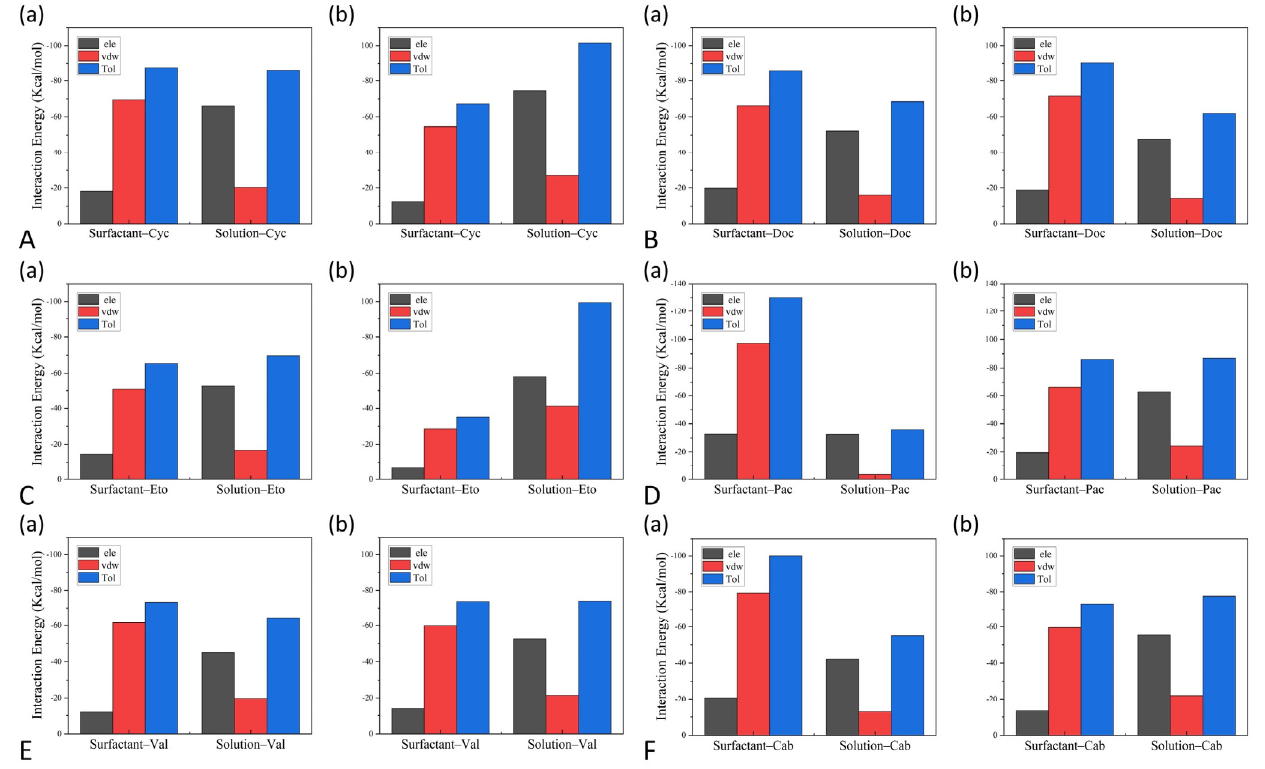
Figure 12. Interaction energies of each binary component of ( a ) the formulations without cosolvents and ( b ) the formulations with cosolvents, where ele stands for the electrostatic interaction energy and vdw refers to the van der Waals interaction energy. ( A ) represents the Cyclosporine system, ( B ) represents the Docetaxel system, ( C ) represents the Etoposide system, ( D ) represents the Paclitaxel system, E represents the Valrubicin system, and F represents the Cabazitaxel system.